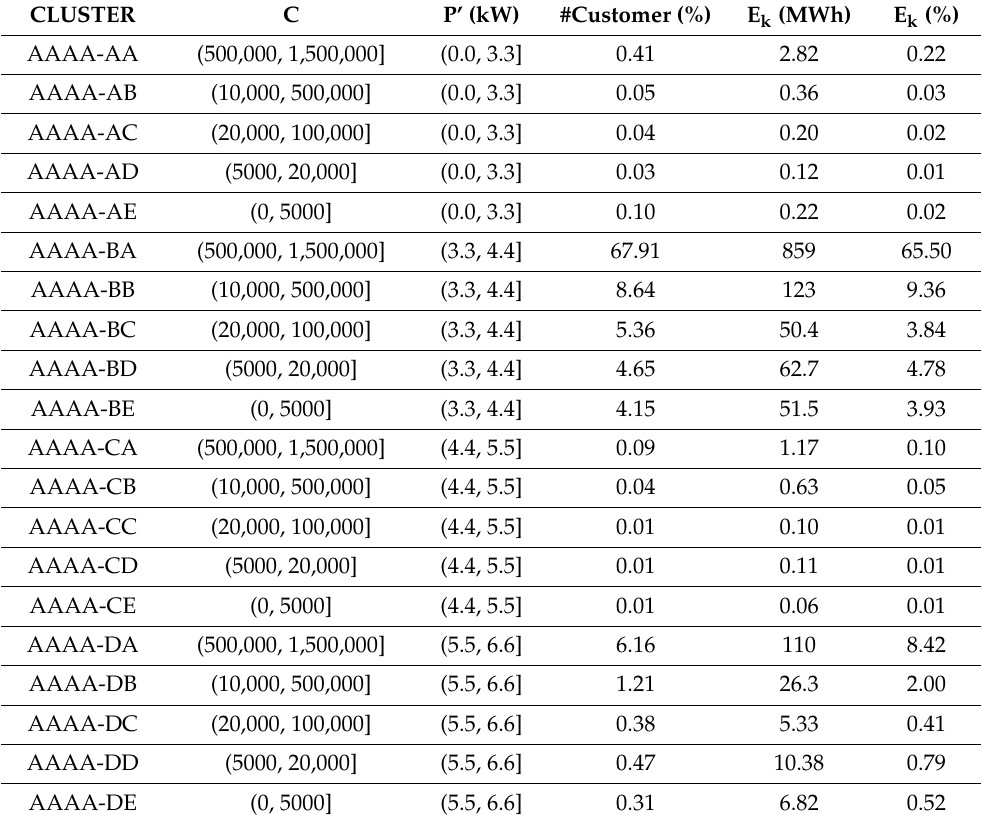
Table 2. Output of sub-clustering cluster